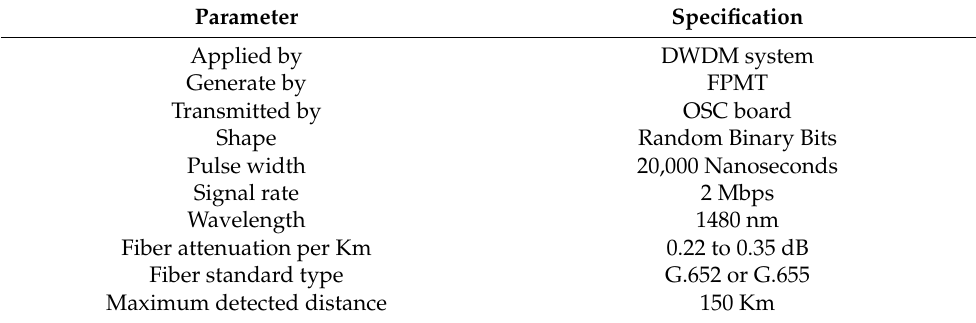
Table 4. The specifications of the test